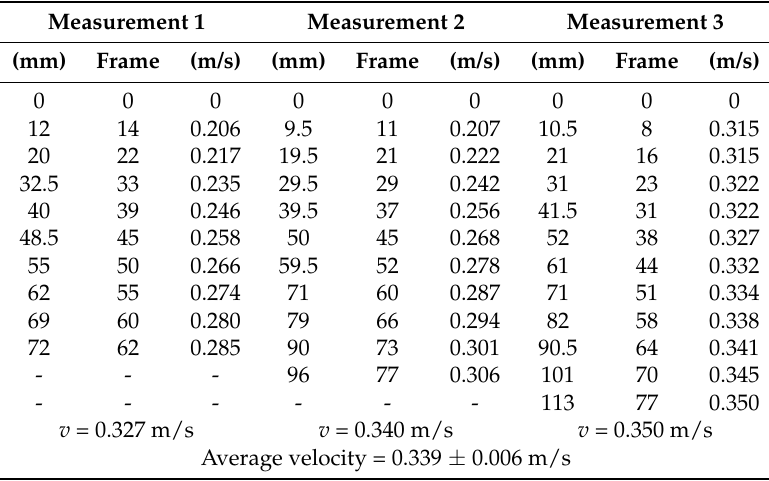
Figure 2. Feed rate estimation of the hammer by linear regression. Table 2. Feed rate of the hammer at different z axes